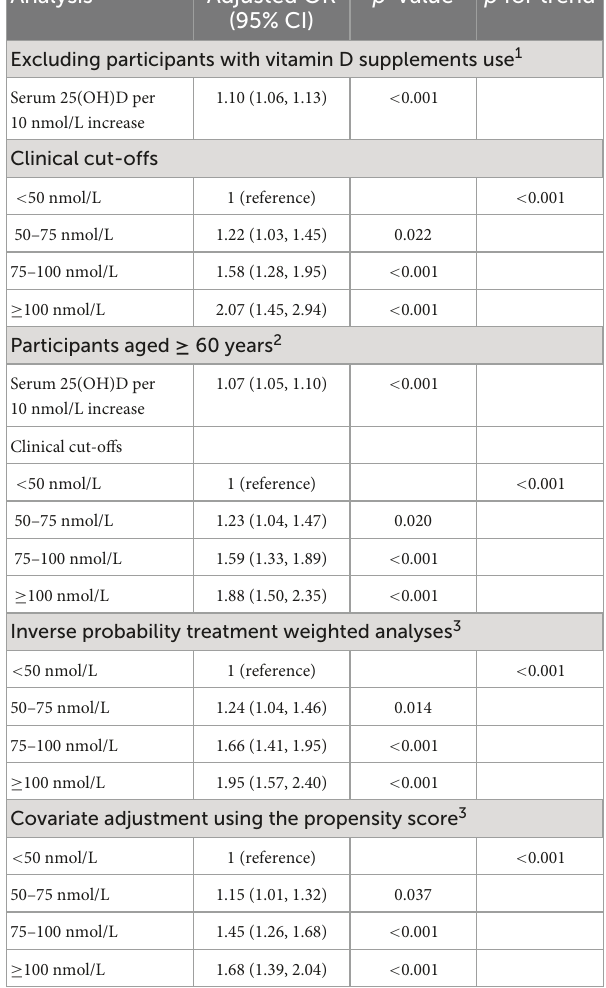
TABLE 3 Multivariate logistic regression analysis between serum 25(OH)D and osteoarthritis. Exposure